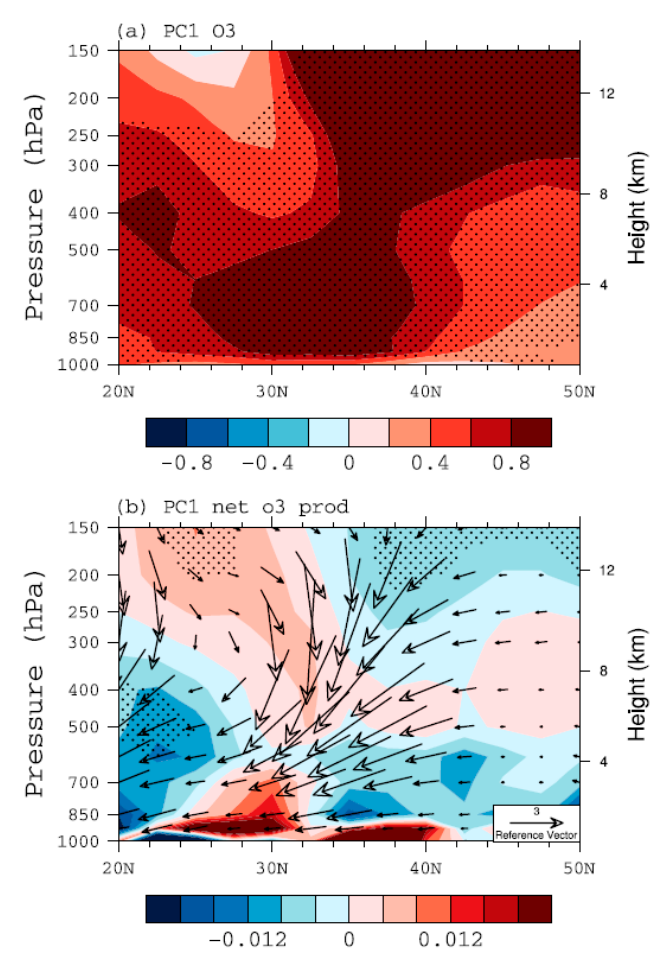
Figure 7. The regressed fields of ( a ) ozone (ppbv) and ( b ) net ozone production (shaded; × 10 − 12 mole m − 3 s − 1 ) overlaid with meridional–vertical circulations (vector; v, -omega) averaged over 120°E–130°E during summer against PC1 from EOF analysis of the detrended ozone (blue line in Figure 5). Black dots indicate statistical significance at the 90% confidence level based on a Student’s t-test.